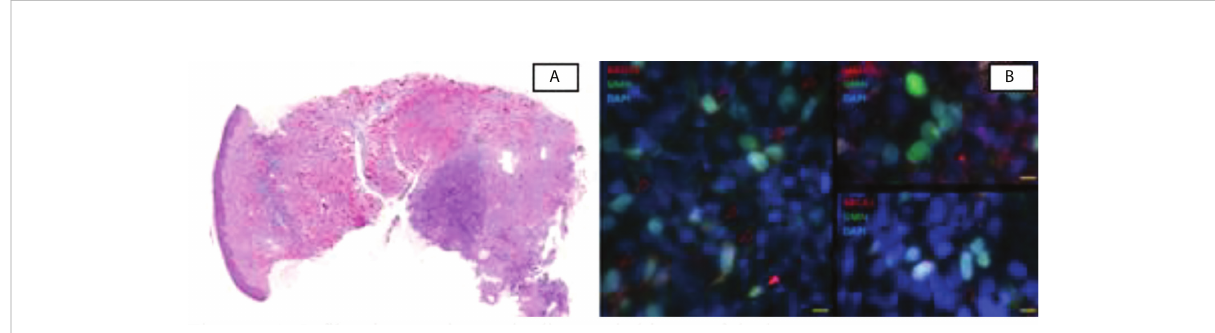
FIGURE 2 (A) In fi ltrating carcinoma in diagnostic biopsy of the breast mass. (B) Representative images of the IF assay to detect biomarkers in the tumor. Geminin (GMN) and DAPI identify cells in S/G2 cell cycle phase. Left , RAD51 nuclear foci are only found in normal cells (closed triangle) but not in tumor cells (open triangles). Right , abundant dsDNA damage ( g H2AX foci) and BRCA1 foci in tumor cells. Scale , 10 µm.